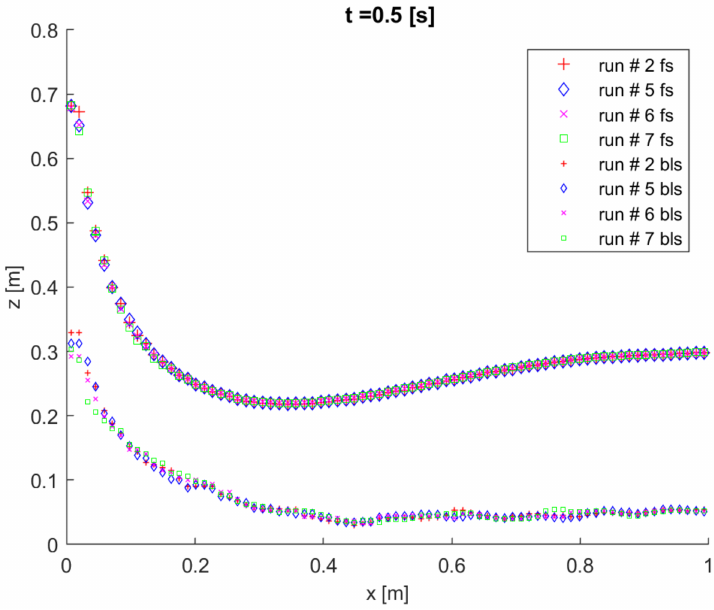
Figure 4. Comparison of free surface (fs) and mixture–water interface (bls) at the reference time t = 0.5 s. Limiting viscosity decreases from Run 2 to Run 6 according to Table